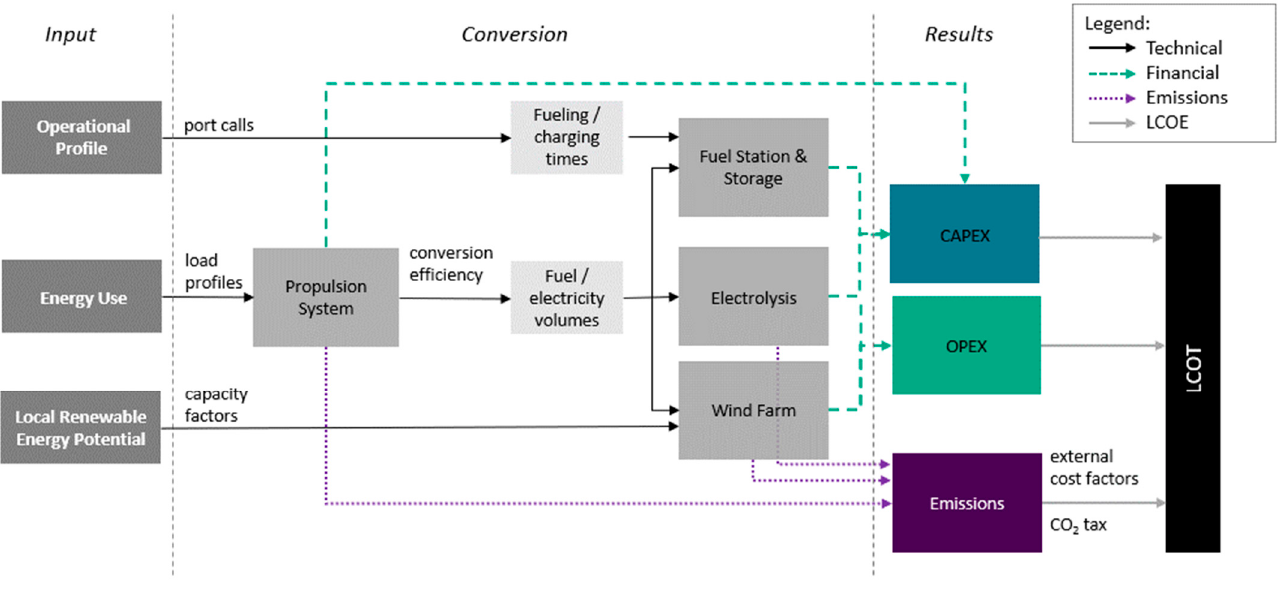
Figure 3. Transfer scheme for the operational profile and energy use of a RoPax ferry, as well as the renewable energy potential of a low-carbon fuel system (Source: By author).